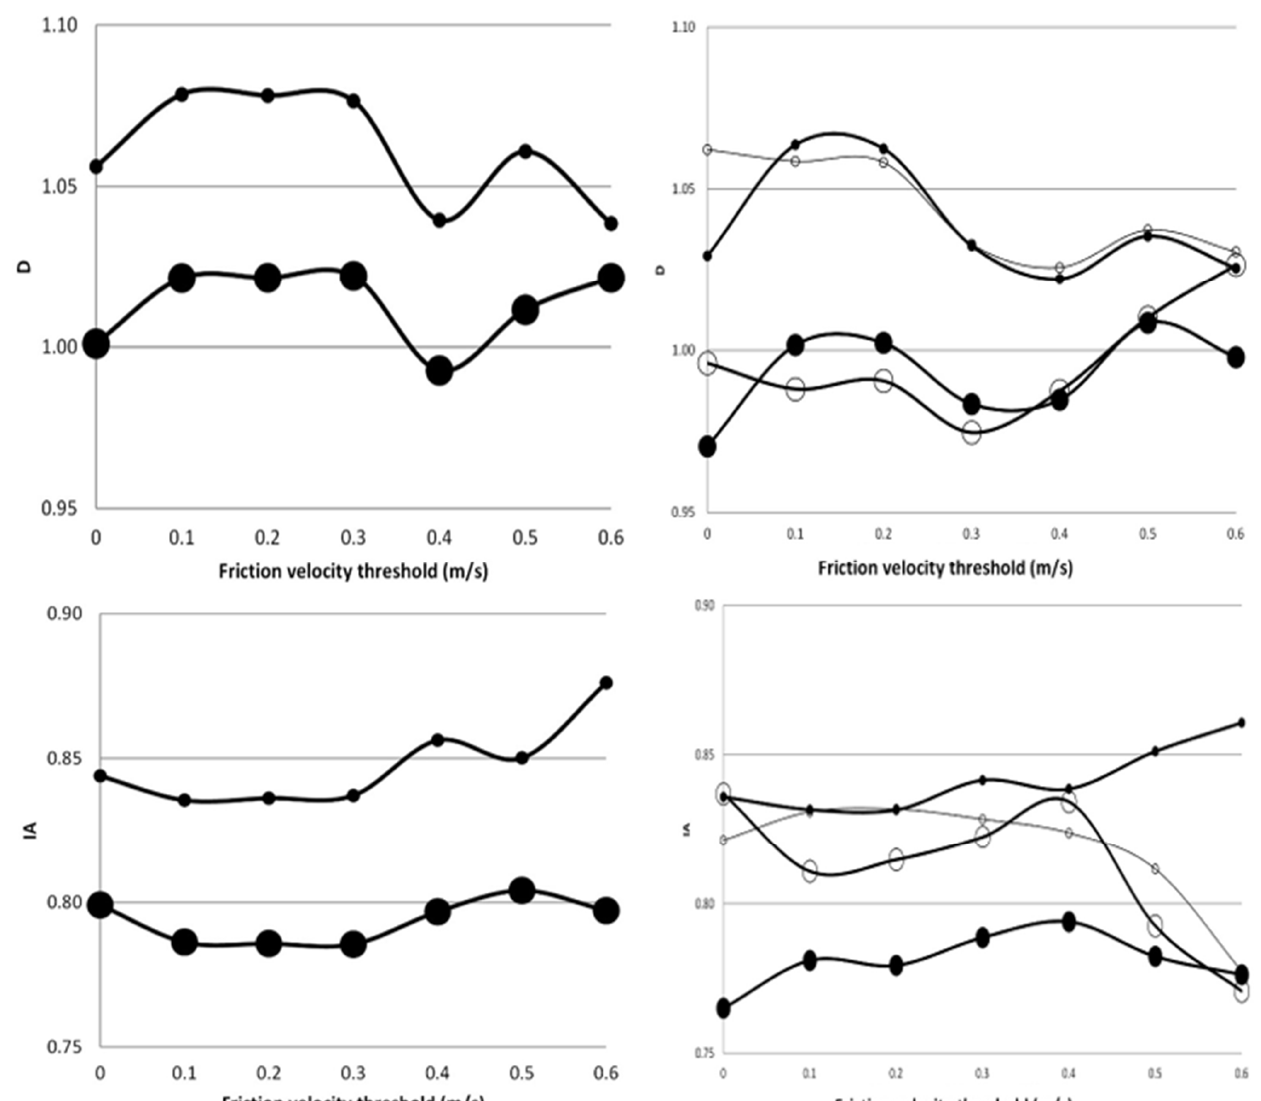
Figure 4. Coefficients D ( top ) and IA ( bottom ) for latent heat flux estimates using the EC (thin solid) and the LST (thick solid) sensible heat flux as input for different friction velocity thresholds in clear sky days (open circle) and cloudy days (solid circle) in July (left panel) and August (right panel). The results of the linear regression analysis obtained for the samples collected during clear sky days (August) showed the λ E R-LST performed close to λ E BREB , λ E R-LST = 0.98 λ E BREB + 4 Wm − 2 , with a coefficient of determination (R 2 ) of 0.89. The bias was negligible (1 Wm − 2 ) and the mean absolute relative error was 9%. For cloudy days in July, it was found: λ E R- LST = 0.96 λ E BREB + 13 Wm − 2 , R 2 =0.85; bias = 0 Wm − 2 , and the mean relative absolute error was 14% (Table 1). For cloudy days in August: λ E R-LST = 0.98 λ E BREB + 3 Wm − 2 , R 2 =0.82, bias = 8 Wm − 2 and the mean relative absolute error was 12%. Thus, - λ E R-LST performed excel- lently.